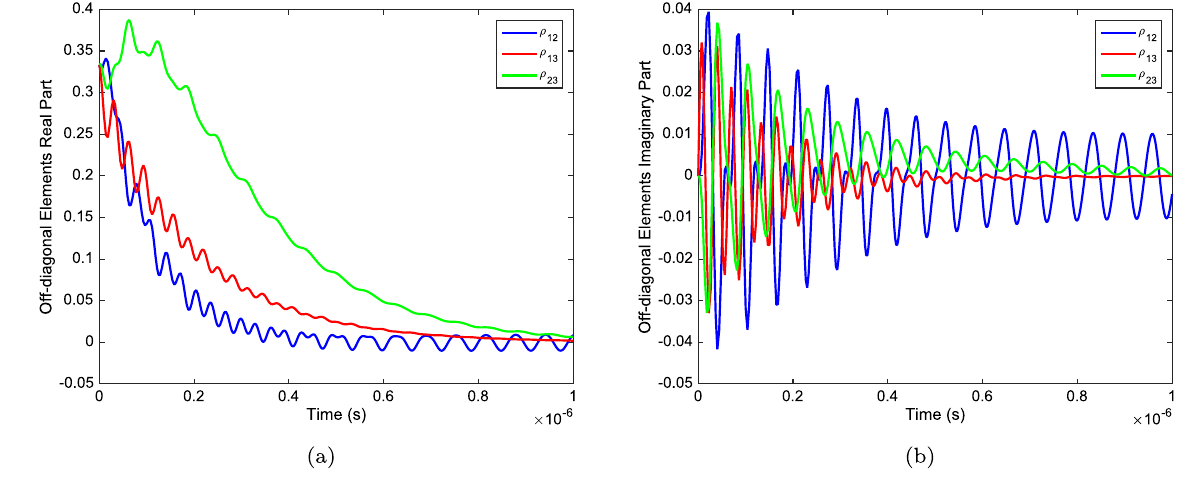
Figure 4. The evolution of ( a ) real parts and ( b ) imaginary parts, of off-diagonal elements of density matrix versus time. With γ